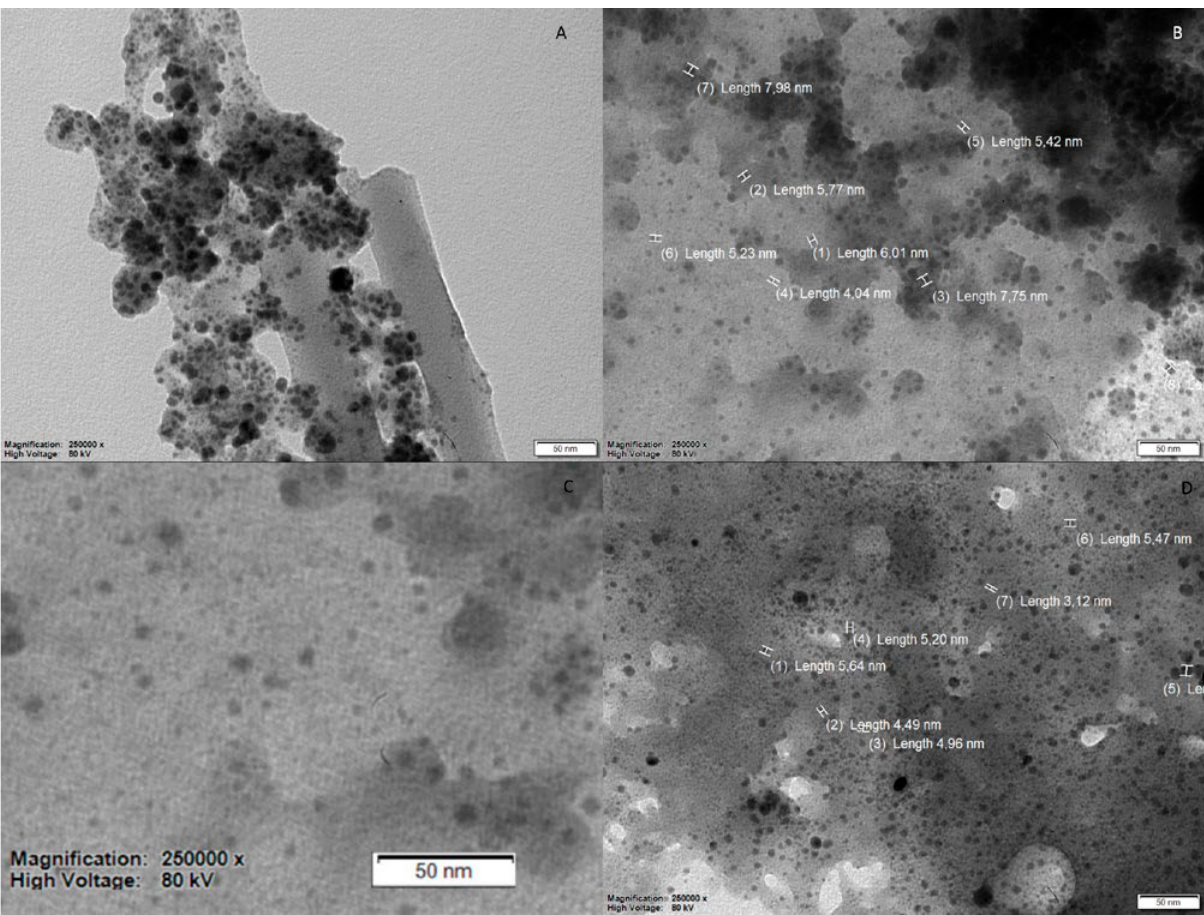
Fig. 3. TEM Image of extracellular synthesized silver nanoparticles A, B. Desmodesmus sp. cell RAE mediated synthesized silver nanoparti- cles (RAE-AgNPs); C, D. Desmodesmus sp. cell BAE mediated synthesized silver nanoparticles